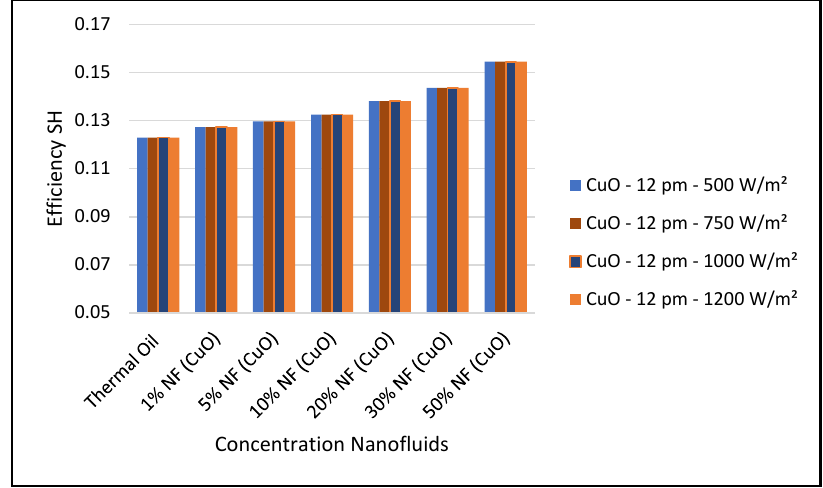
ffi ciency at CuO nanofluid and di ff erent Figure 31. CSP system hybrid efficiency at CuO nanofluid and different concentrations. Figure 31. CSP system hybrid e